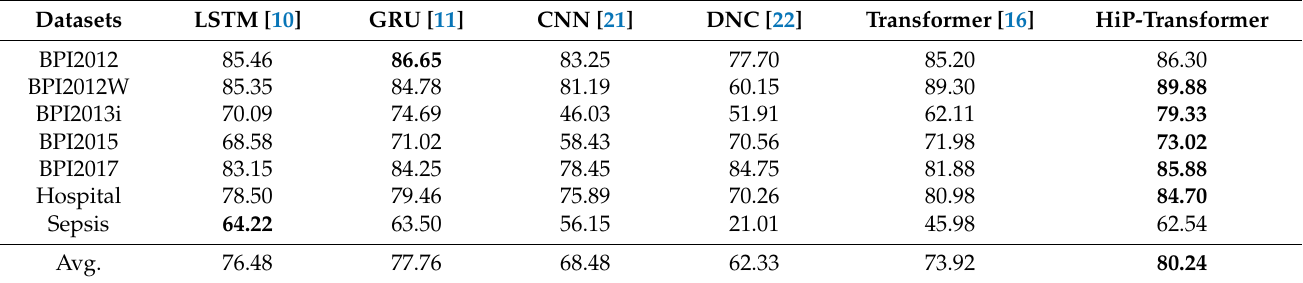
Table 2. Accuracy of next executing activity prediction (accuracy: